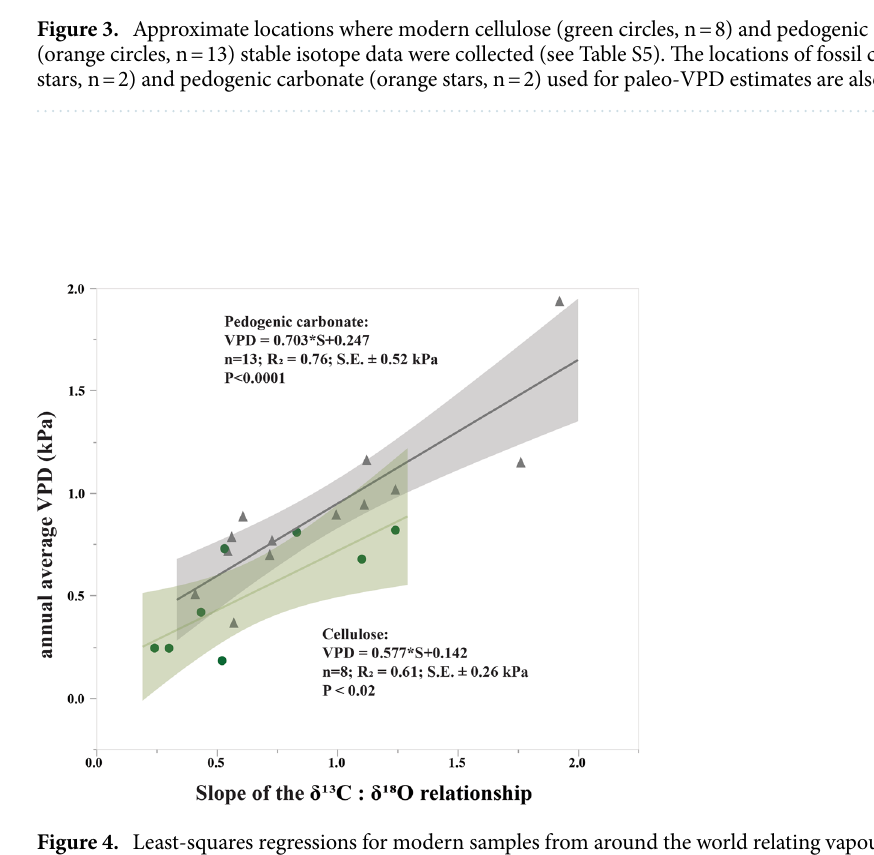
Figure 4. Least-squares regressions for modern samples from around the world relating vapour pressure deficit (VPD) and the slope of the positive correlation between δ 13 C and δ 18 O ( S ) in modern tree-ring cellulose (circles) and modern pedogenic carbonate (triangles). No fossil data are shown in this figure. Shaded areas are 95% confidence prediction intervals. Propagated error (S.E.) for VPD predictions using cellulose (± 0.26 kPa) and pedogenic carbonate (± 0.52 kPa) were calculated from A) the standard error of each modern data point’s δ 13 C:δ 18 O slope when slope was calculated from raw data; B) the standard error of modern VPD measurements when calculated from average climate statistics (± 0.13 kPa) 41,42 ; and C) the standard error of the transfer